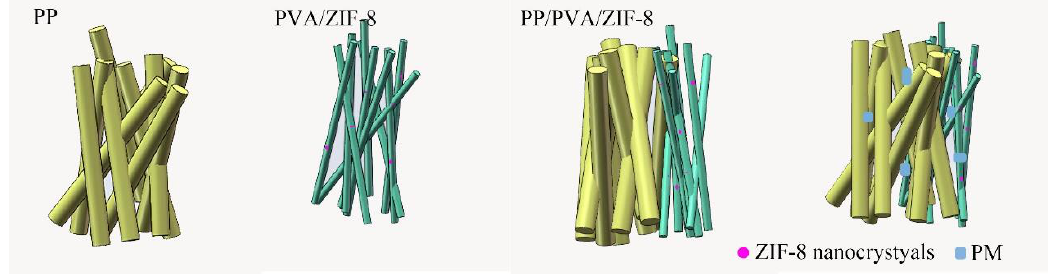
Figure 6. Filtration mechanism of PP/PVA/ZIF-8 melt-blown electrospun composite membranes.